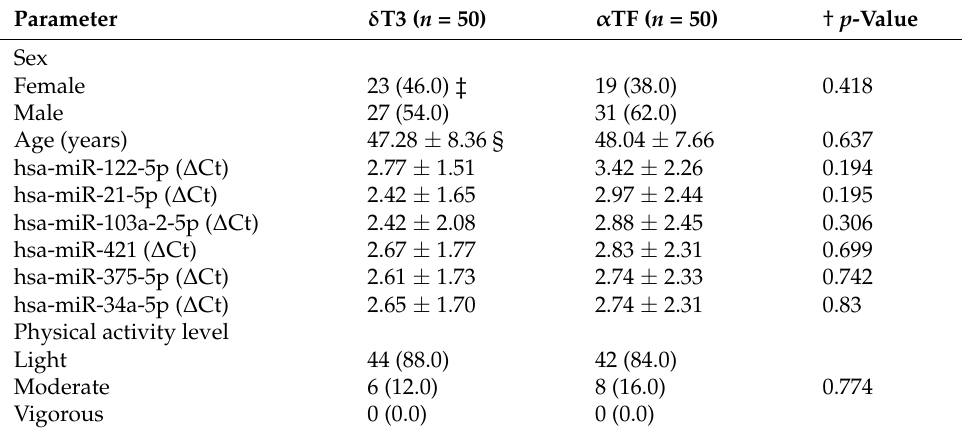
Table 1. Baseline characteristics of patients in each group.